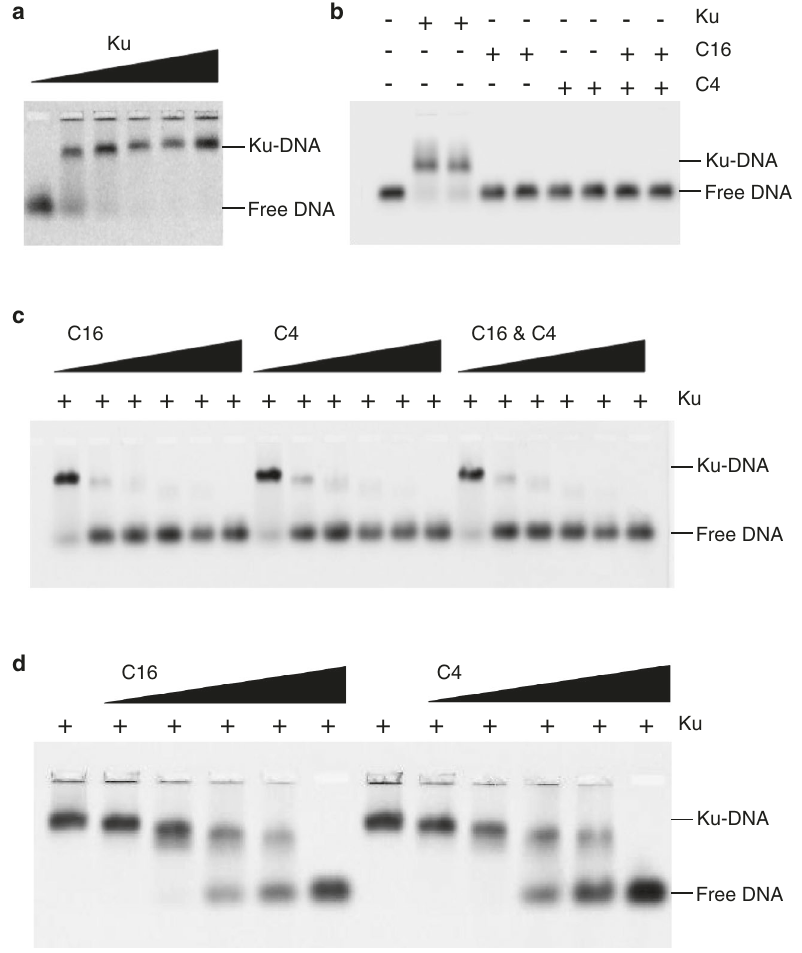
Fig. 1 | C16 and C4 block DNA binding to Ku. a Electrophoretic mobility shift assays (EMSA). A 5 ′ Cy3-labelled 19-bp duplex oligonucleotide (10nM) was incu- batedwith increasingamounts of recombinant Ku(0, 5,10, 20,30and 40nM)and theexperimentvisualisedbythe fl uorescenceoftheCy3labelattachedtotheDNA. The upper band indicates binding of DNAbythe Kuheterodimer. b The same DNA substrate was incubated with recombinant Ku (20 and 30nM), recombinant VACV C16 (100 and 150nM), recombinant VACV C4 (100 and 150nM) or C16 and C4 together (50 and 75nM each). Neither of the VACV proteins bind DNA individually or in combination. c The same DNA substrate as in a was incubated with recom- binant Ku (30nM) in the presence of increasing amounts of C16 (5, 10, 20, 40, 80